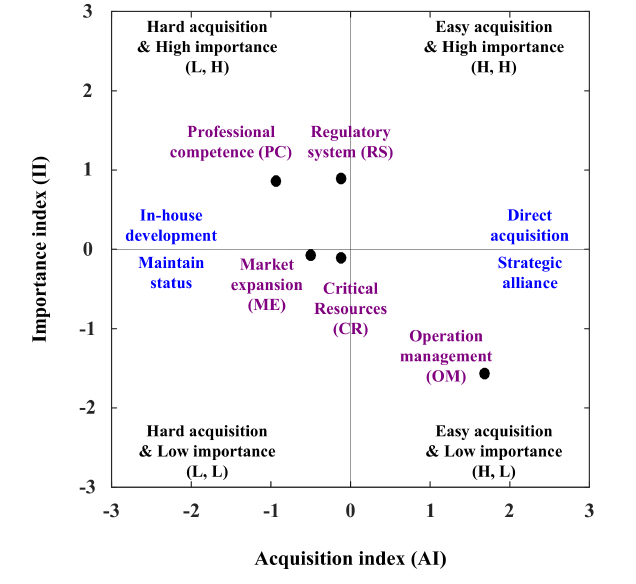
Figure 3. The AIA (acquisition–importance analysis)